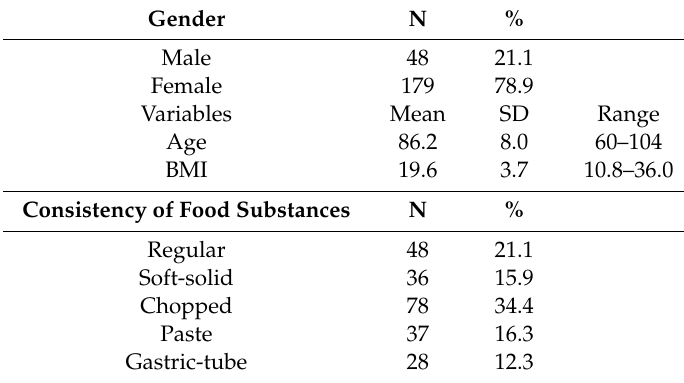
Table 1. Feature of